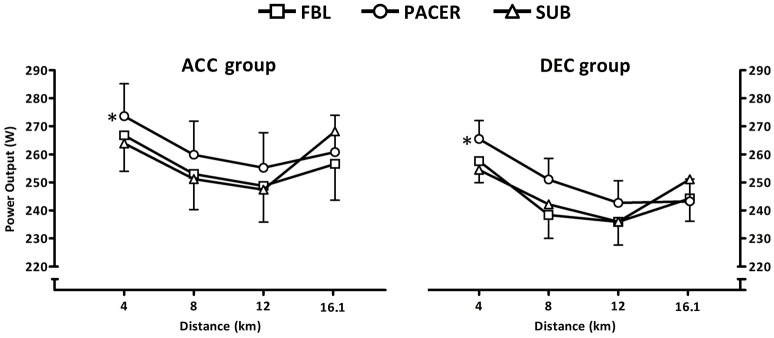
Mean (SEM) power output at each distance quartile in 16.1 km time trials for the ACC and DEC groups. *Denotes significantly higher mean power output than FBL and SUB (P < 0.001).